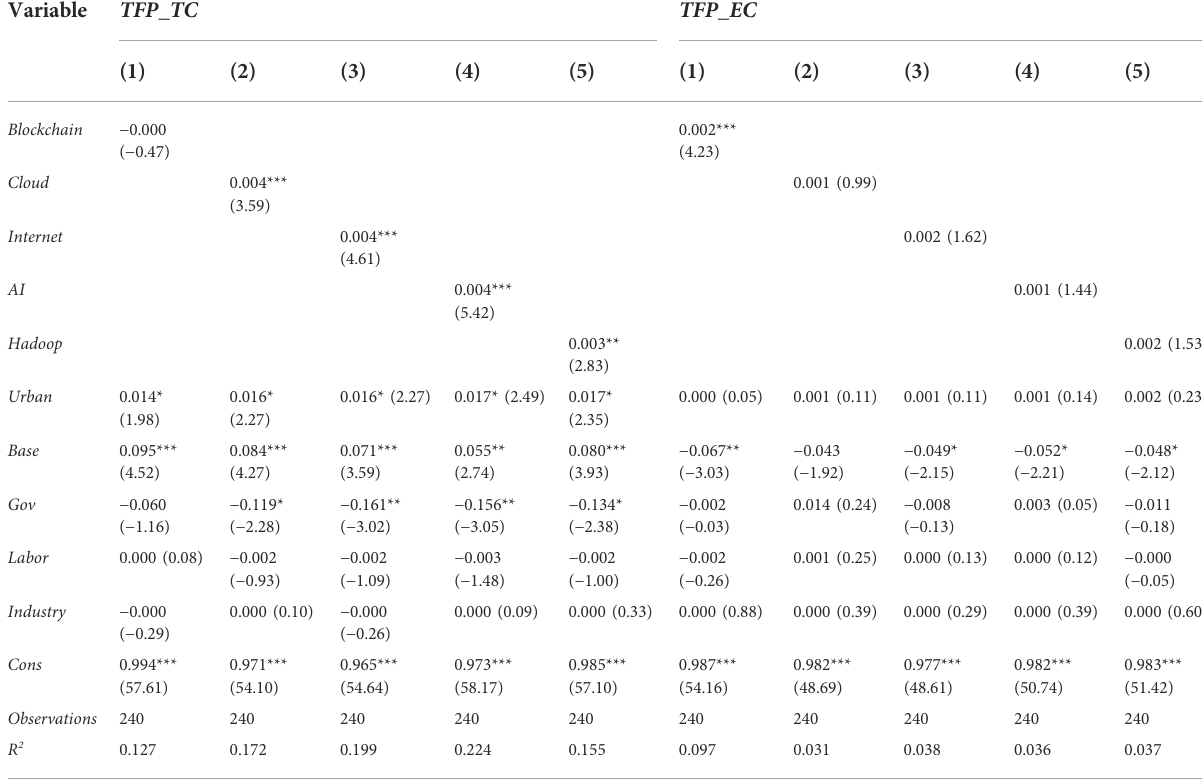
TABLE 4 Empirical results of big data sub-indicators ’ impact on green economic